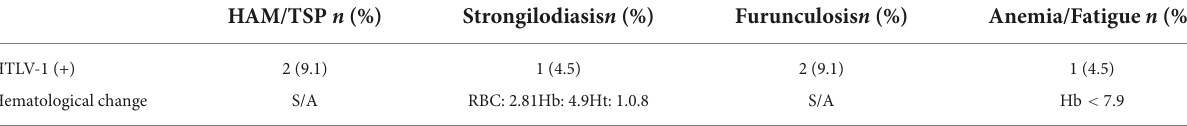
TABLE 7 Clinical findings of the human T-lymphotropic virus type 1 (HTLV-1)-positive patients associated with hematological changes. HAM/TSP n (%) Strongilodiasis n (%) Furunculosis n (%) Anemia/Fatigue n (%) HTLV-1 (+) 2 (9.1) 1 (4.5) 2 (9.1) 1 (4.5) Hematological change S/A RBC: 2.81Hb: 4.9Ht: 1.0.8 S/A Hb <